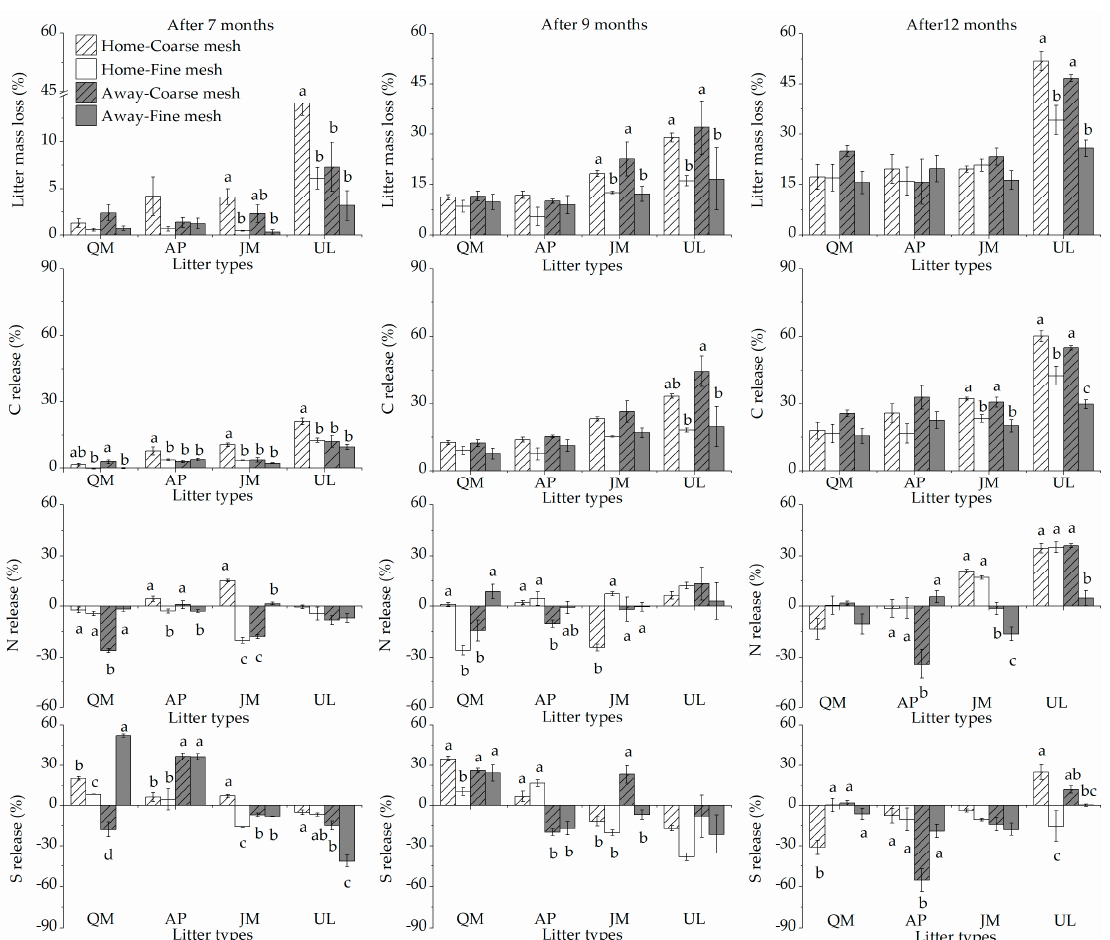
Figure 1. Mean litter mass loss and nutrient release of different litter types during the experimental period. Values are the mean ± SE ( n = 3). Lowercase letters indicate significant differences among the home-coarse mesh, home-fine mesh, away-coarse mesh, and away-fine mesh litterbags within the same litter types in the same experimental periods.